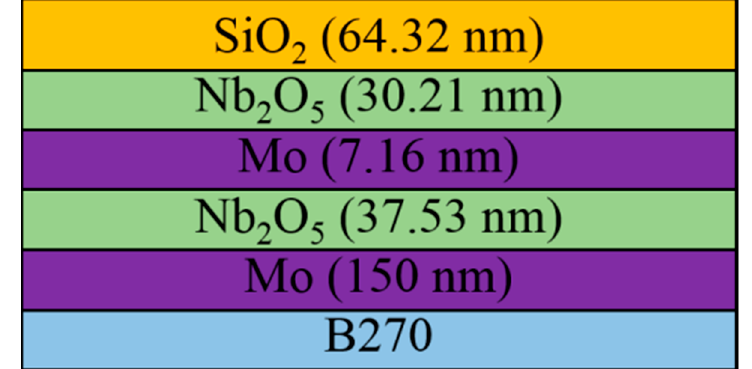
Figure 10. Optimization design of solar selective absorber.